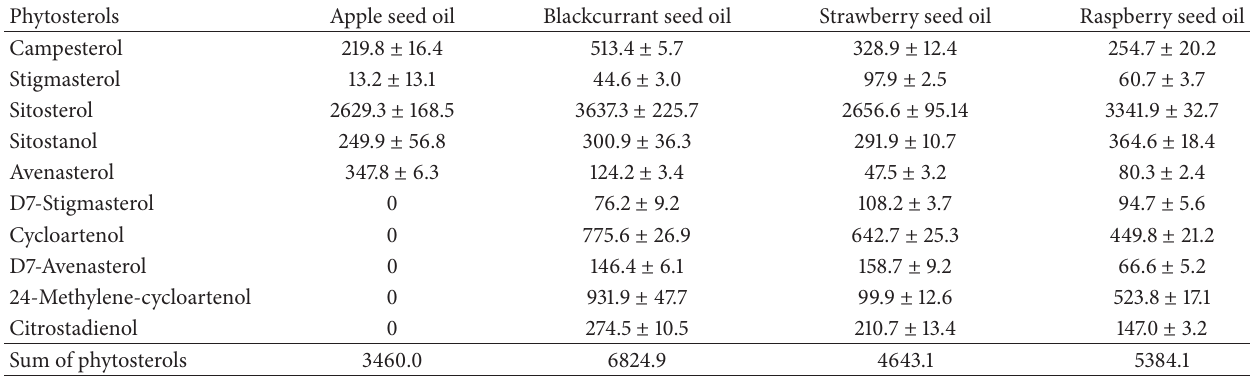
Table 4: Phytosterol content of oils from apple, blackcurrant, strawberry, and raspberry seeds ( 𝜇 g/g).